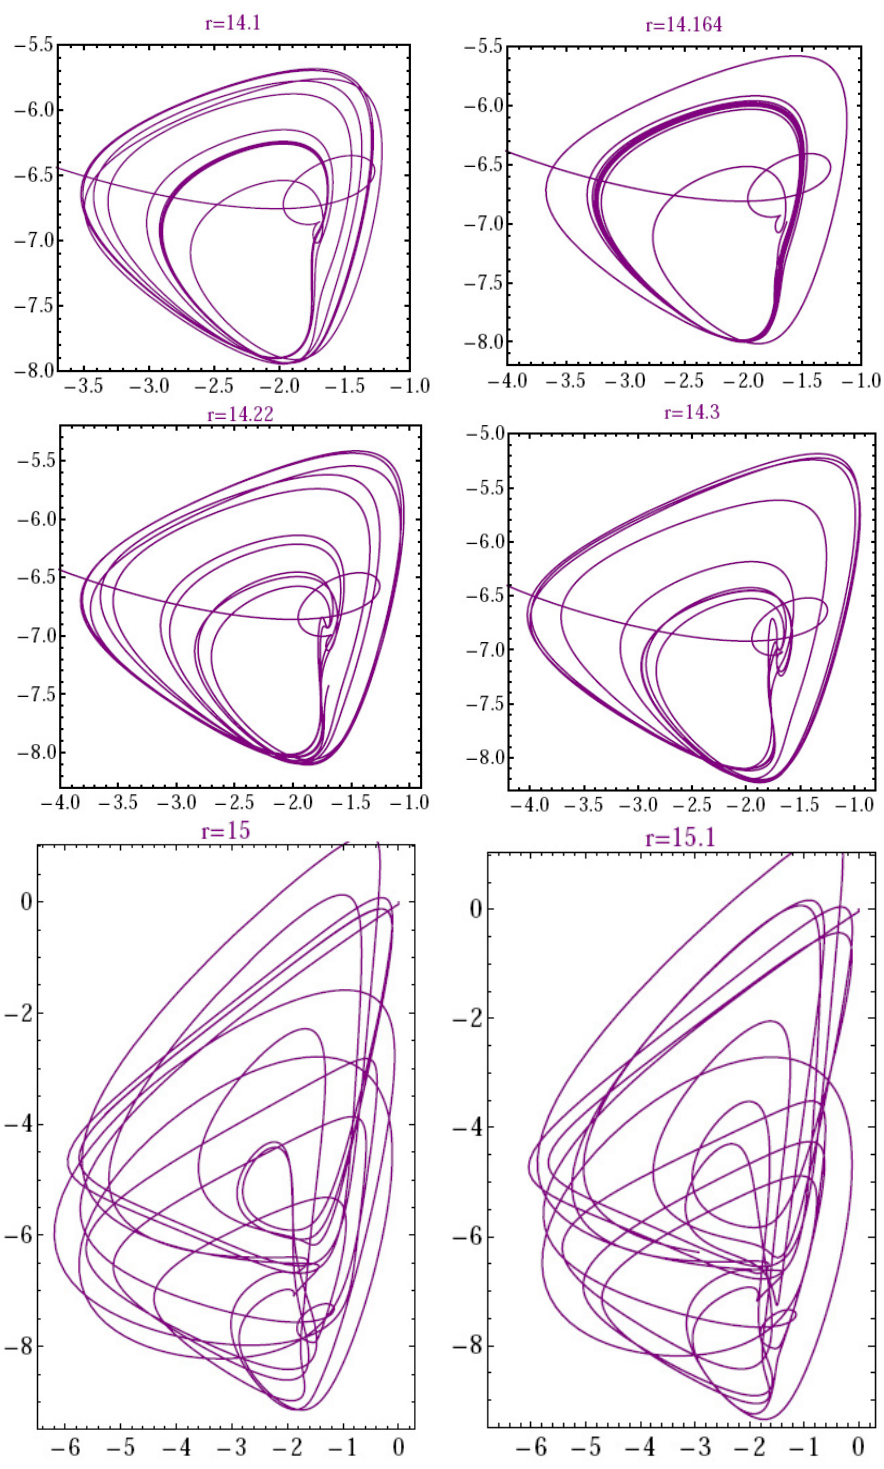
Figure 5. The hyper-chaotic situation in the case of the φ 6 − φ 7 plane versus different values of r